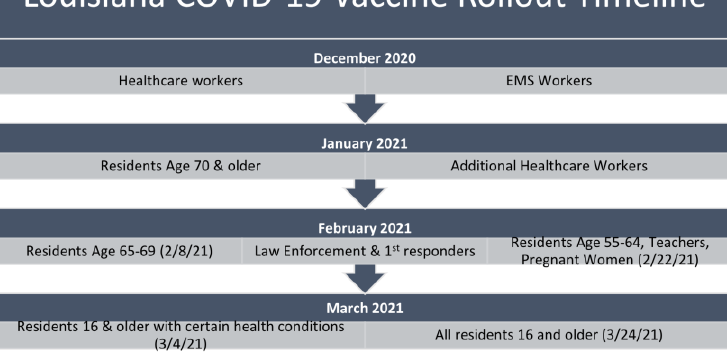
Figure 2. Louisiana COVID-19 Vaccine Phased Roll-out [23].